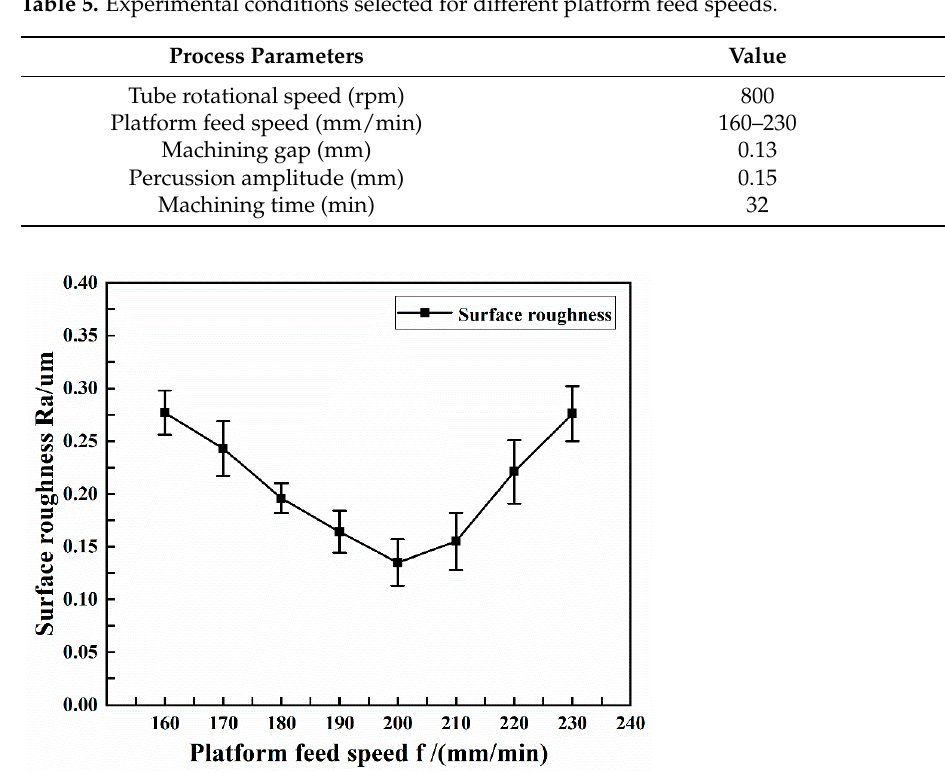
Figure 8. Effect of tube rotational speed on surface roughness.